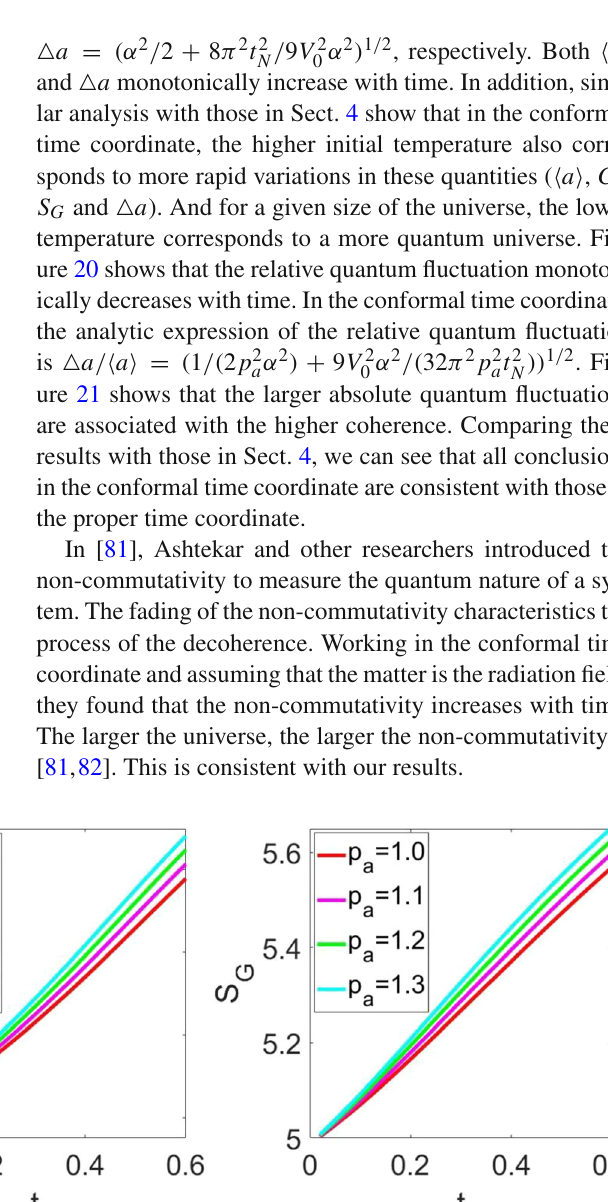
Thus, the parameters p a , α , V 0 and (cid:7) H φ (cid:2) are not independent.